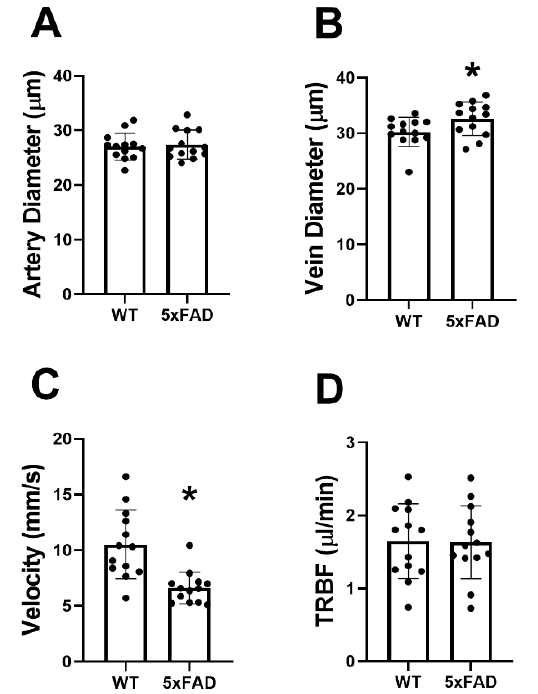
Figure 2. Retinal vessel diameter, venous blood velocity, and total retinal blood flow (TRBF) in wild-type (WT) and five-familial Alzheimer’s disease (5XFAD) mice. ( A ) Retinal arterial diameter, ( B ) venous diameter, ( C ) venous velocity, and ( D ) TRBF in WT and 5XFAD groups. The data are presented as mean ± SD. * p < 0.05.